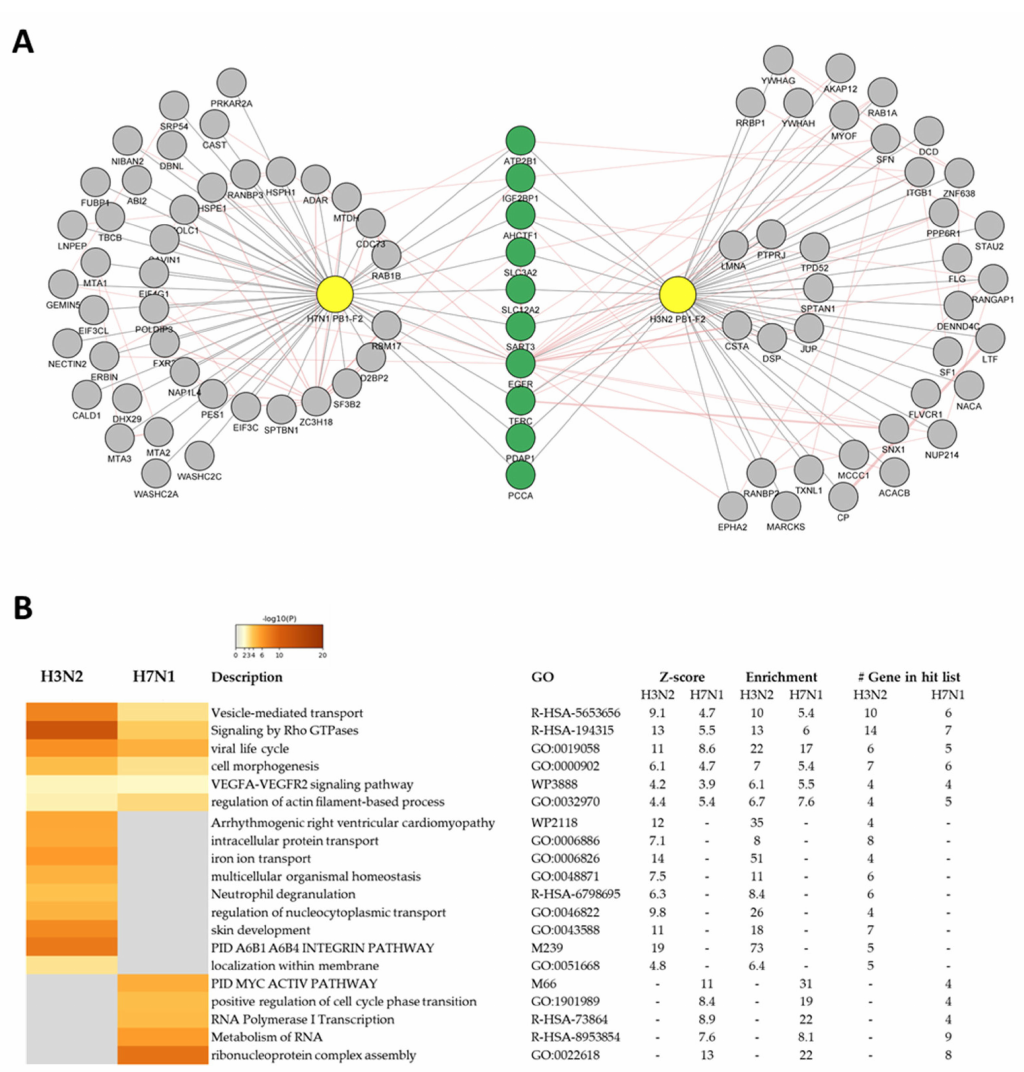
Figure 4. ( A ) Superposition of protein/protein interaction networks of PB1-F2 from H7N1 and H3N2 viruses. The common partners of both PB1-F2 are colored green. ( B ) Cluster of statistically enriched terms (GO/KEGG terms, canonical pathways). Accumulative hypergeometric p-values and enrichment factors were calculated and used for filtering. The remaining significant terms were then hierarchically clustered into a tree based on Kappa-statistical similarities among their gene memberships. Then 0.3 kappa score was applied as the threshold to cast the tree into term clusters. The term with the best p-value within each cluster as its representative term and display them in a dendrogram. The heatmap cells are colored by their p -values, gray cells indicate the lack of enrichment for that term in the corresponding gene